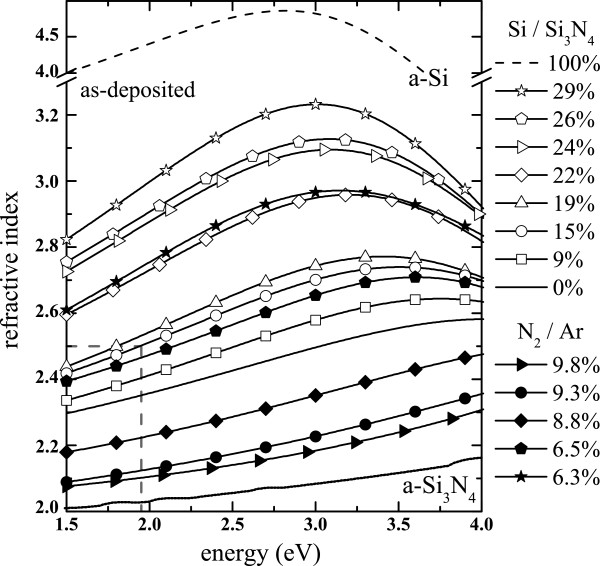
Evolution of the dispersion curves of SiNxthin films. The films were produced by the N2-reactive (full symbols) and the co-sputtering (empty symbols) methods as a function of the Ar/N2 gas flow ratio and the Si/Si3N4 target power ratio, respectively. The dispersion curve of Si3N4 from [28] is shown for comparison.